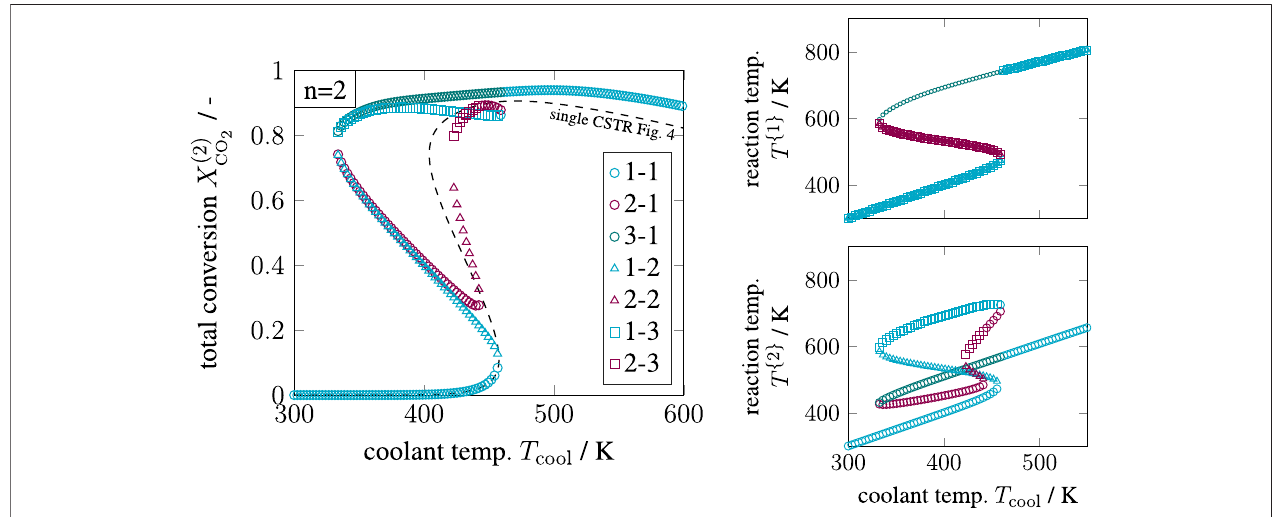
FIGURE8| Enumerativesolutionofsigni fi cantoperatingpointsinatwo-stageCSTRseries,referencesettingtakenfrom SupplementaryTableS1 but T in (cid:2) T cool . Note: T cool is constant over the entire cascade, whereas T op changes in each CSTR stage.